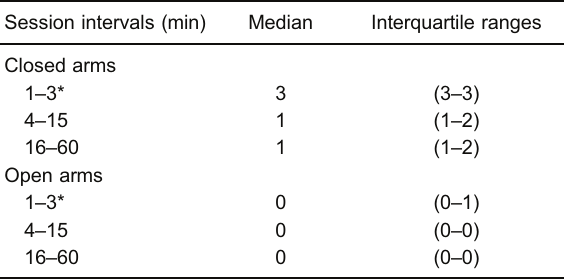
Table 1. Frequency of closed and open arm entries by rats during the fi rst 60 min of the session. Session intervals